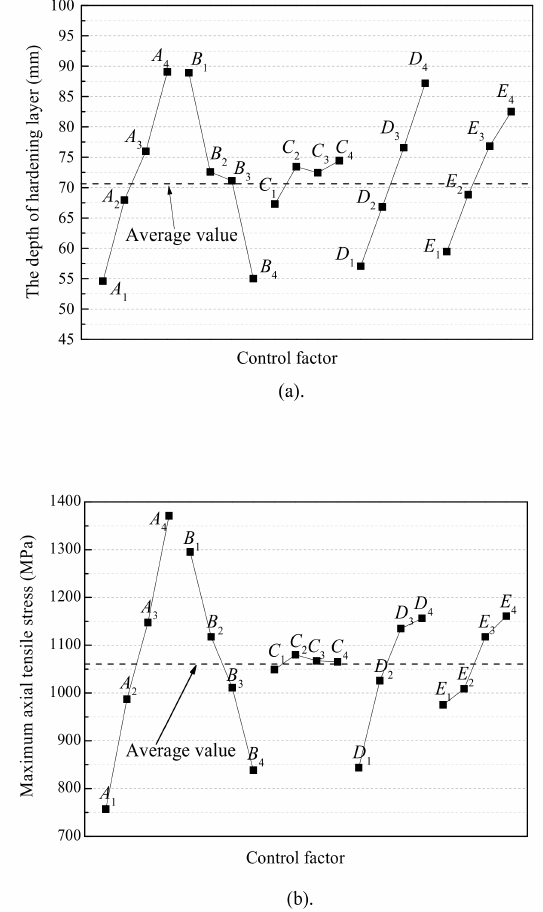
Figure 3. Main e ff ect diagram of ( a )the depth of hardened layer and ( b ) maximum axial tensile